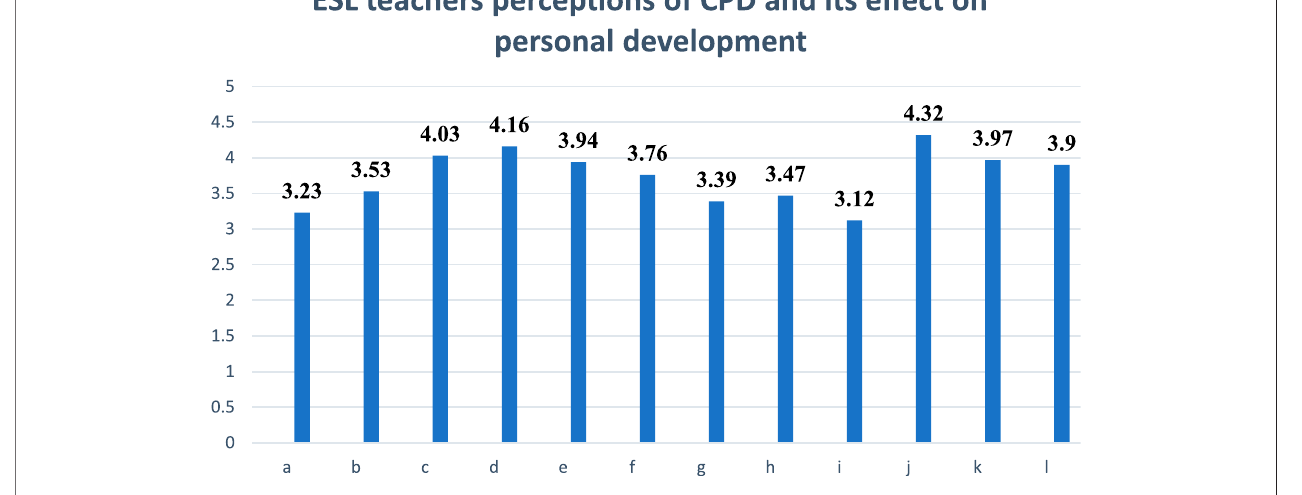
FIGURE 2 | EFL teachers ’ perceptions regarding CPD For professional